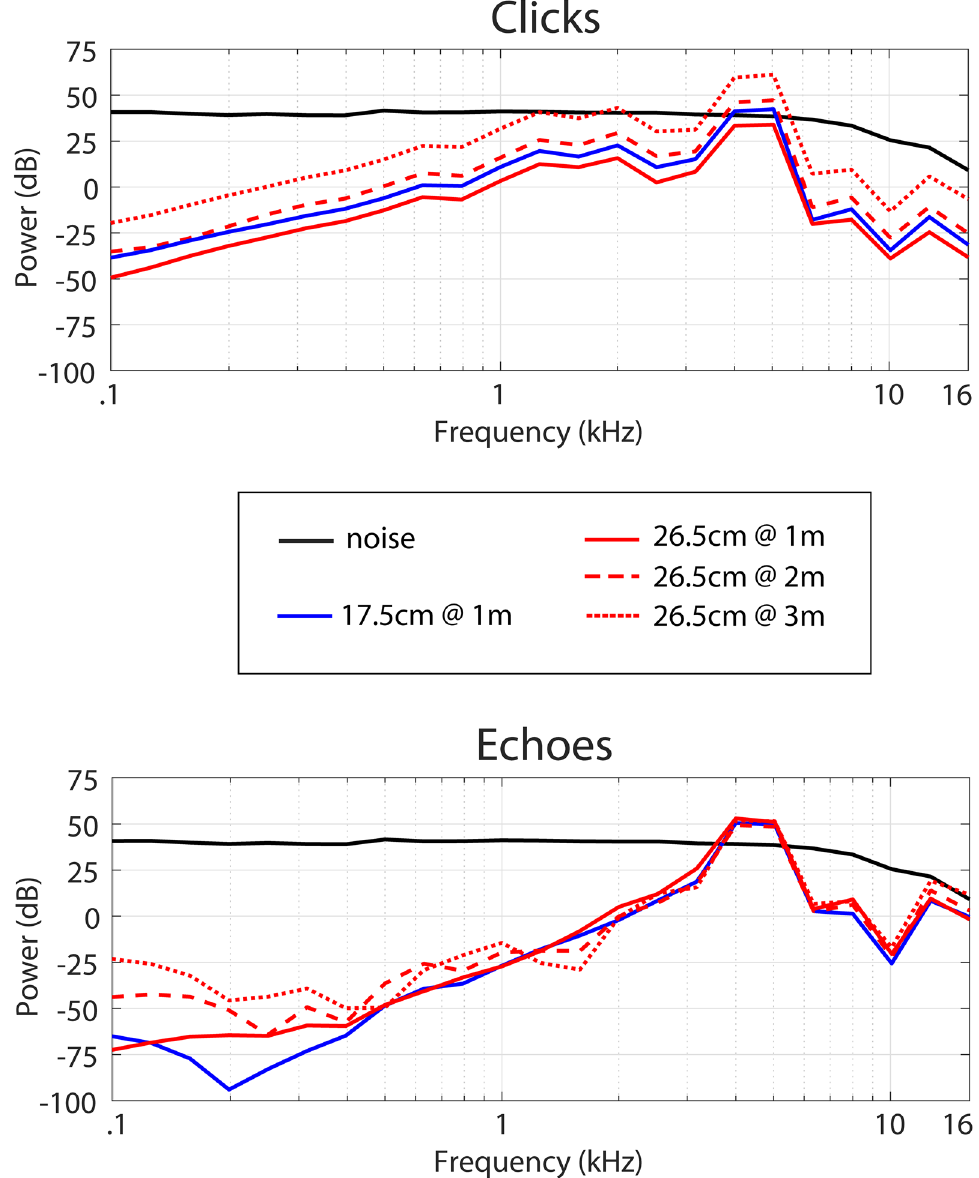
Figure 7. Power spectra (1/3 Octave Bands) for noise and clicks (top panel) and noise and echoes (bottom panel). Black lines denote data for noise, and red and blue solid and dashed lines denote data from clicks and echoes in the various